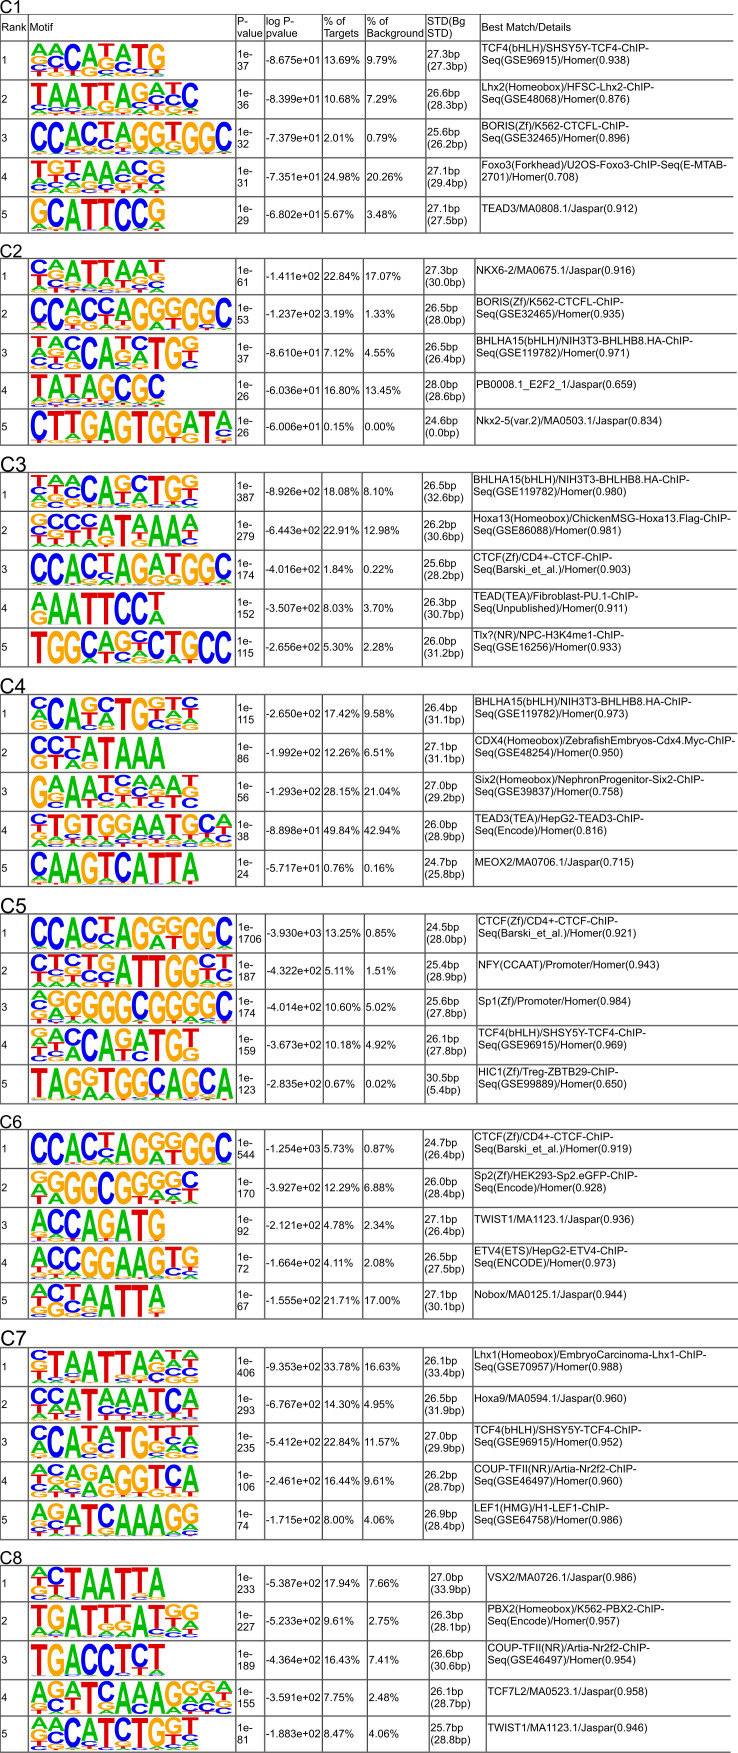
De novo motif discoveries of ATAC-seq peaks.The top five motifs from each cluster. See Supplementary data for the full list of motifs. C1–C8 correspond to the clusters in Figure 6A.